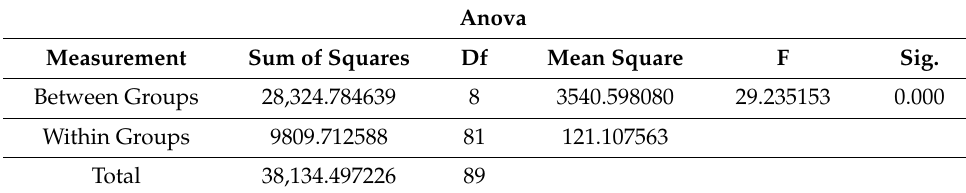
Figure 4. Means plot of precision for each scanner. Table 4. Anova sig. between